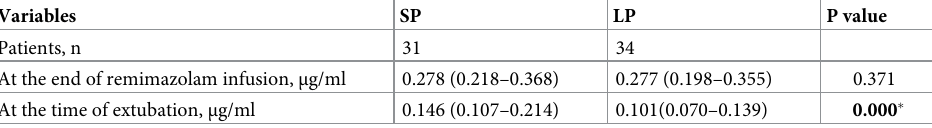
Table 2. Predicted plasma concentration of remimazolam in LP and SP groups. Variables SP LP P value Patients, n 31 34 At the end of remimazolam infusion, μ g/ml 0.278 (0.218–0.368) 0.277 (0.198–0.355) 0.371 At the time of extubation, μ g/ml 0.146 (0.107–0.214) 0.101(0.070–0.139) 0.000